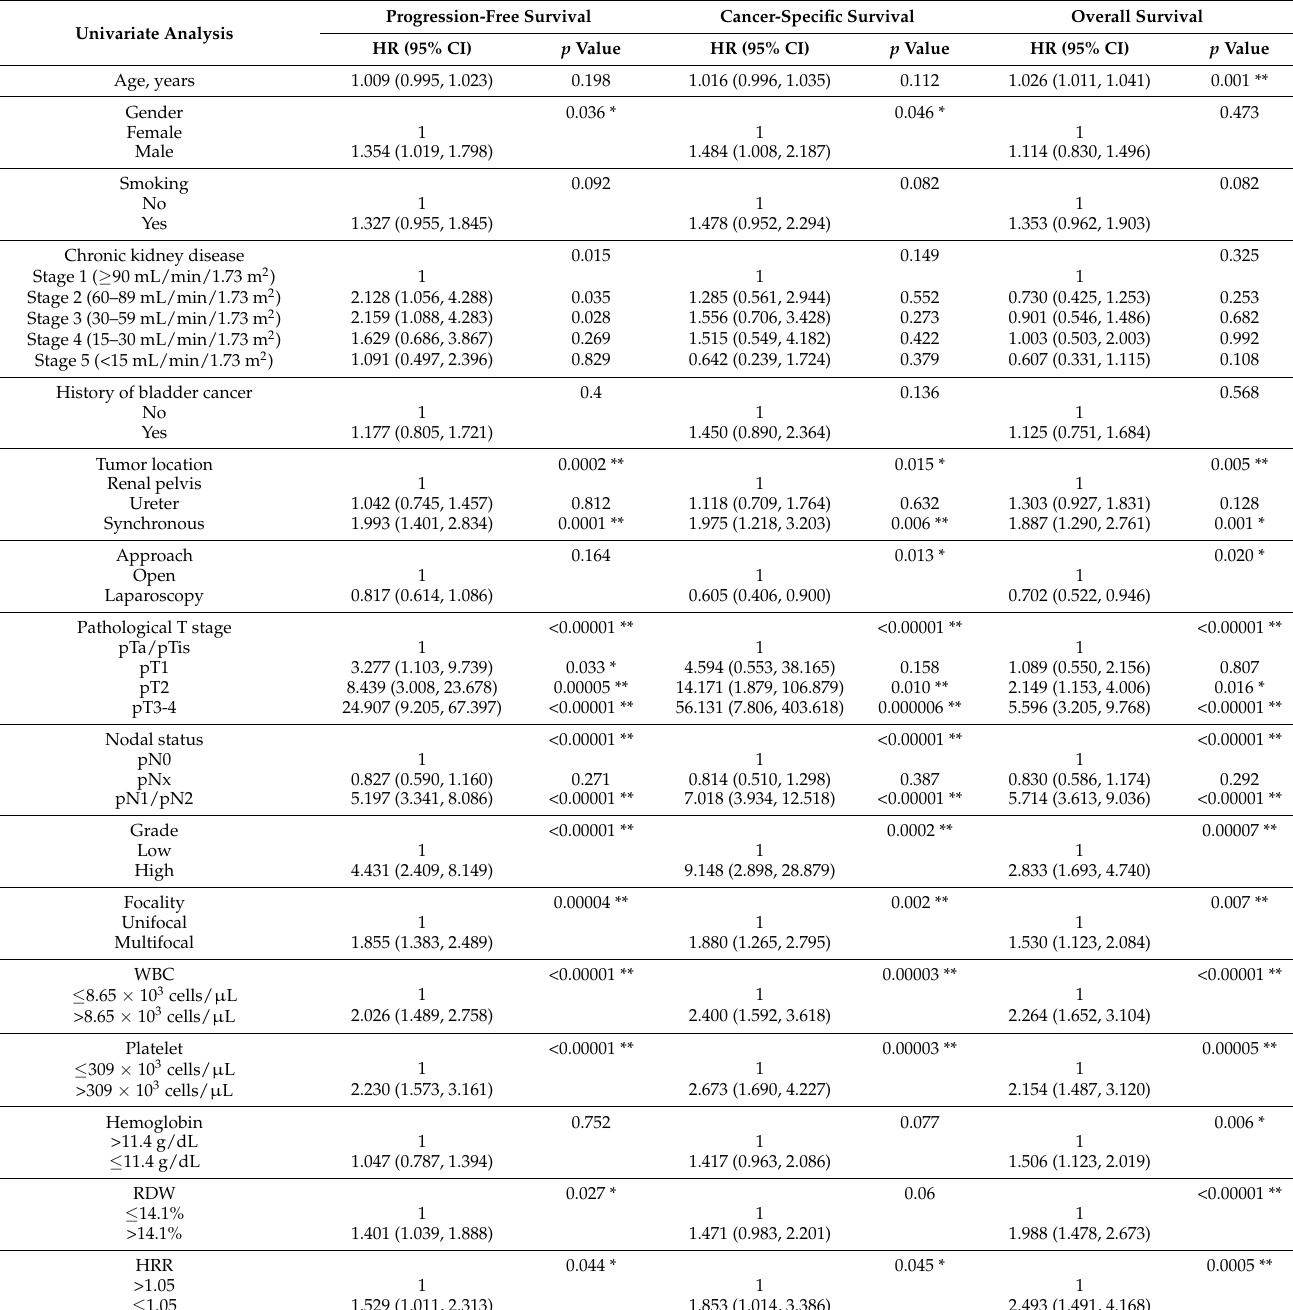
Table 2. Comparative univariate survival analyses of 730 patients with upper tract urothelial carcinoma (UTUC). Progression-Free Survival Cancer-Specific Survival Overall Univariate Analysis